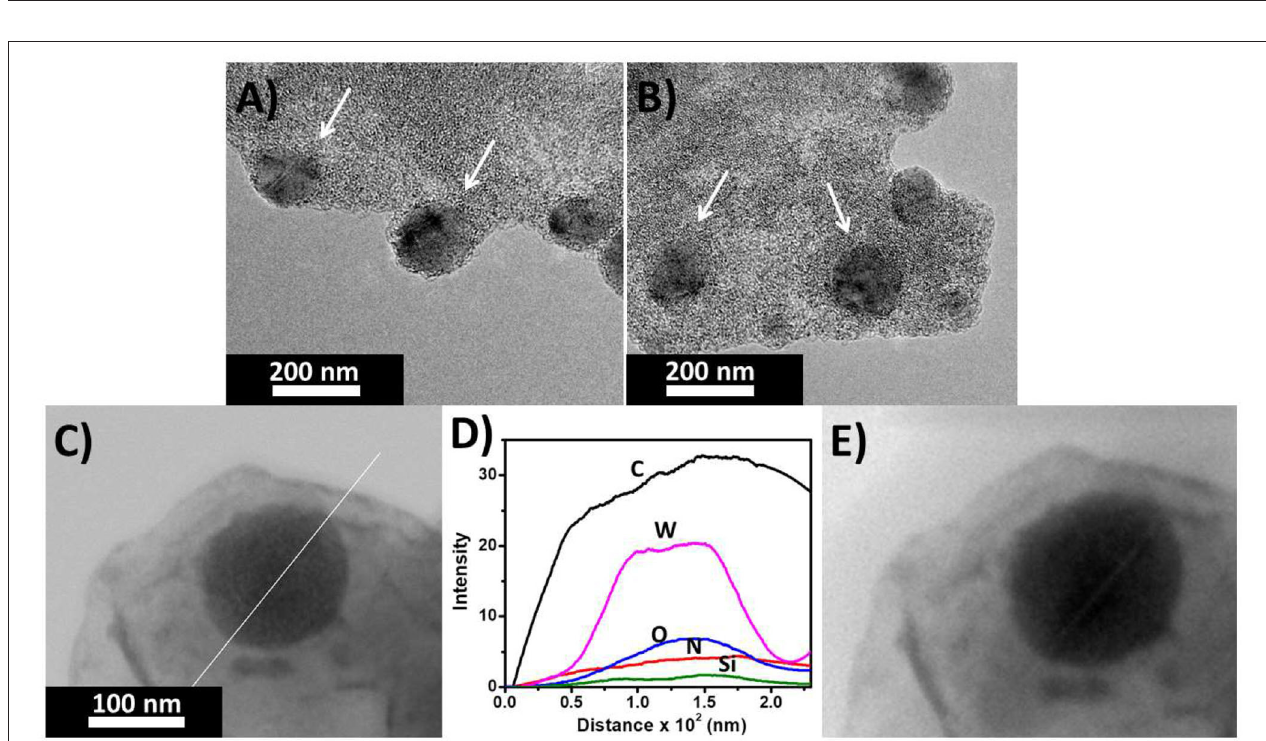
FIGURE 5 | (A,B) TEM image of the SOM vesicles of (C 25 H 26 N 4 ) 4 [SiW 11 O 39 ] (C) Line scan image and (D) plot of intensity of different elements along the line. (E) Beam-damaged image of the hybrid after line